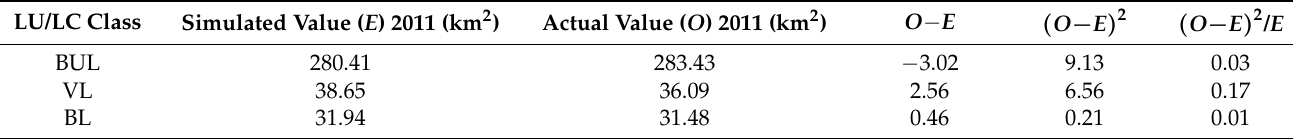
Figure 8. The simulated ( left panel) and actual ( right panel) Mashhad city LU/LC maps for 2011. Table 7. Validation statistics of Markov model LST map prediction for 2019. Table 6. Validation statistics of Markov model LU/LC prediction for 2011 for built-up land (BUL), vegetation land (VL), and bare land (BL) classes.